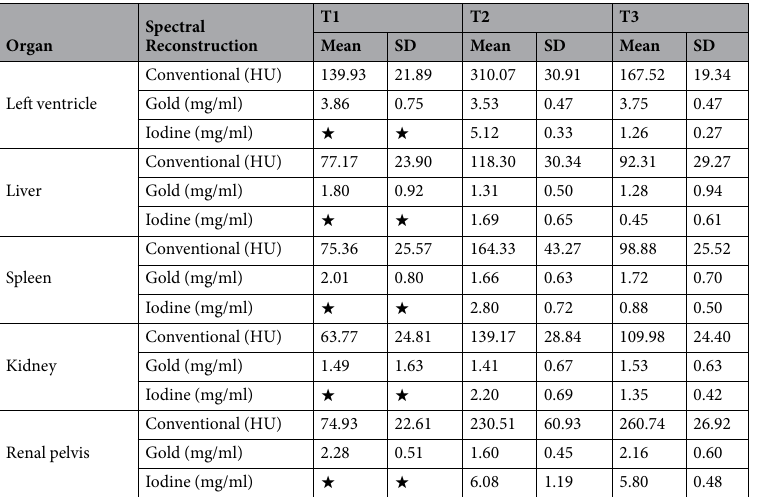
Table 1. Values of attenuation and concentrations of gold and iodine in various organs. Note - data are means ± standard deviation. ★ Absence of iodine contrast